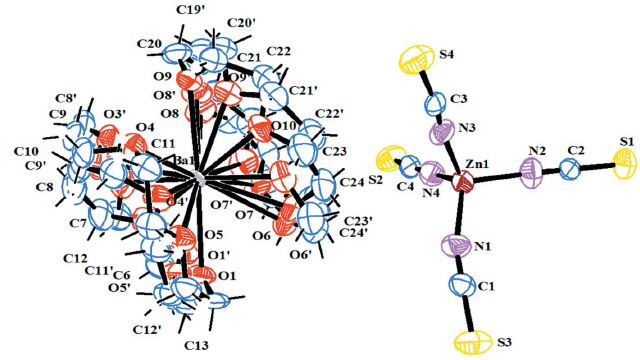
Figure 1 The molecular structure of the title compound, with atom labels and 30% probability displacement ellipsoids for non-H